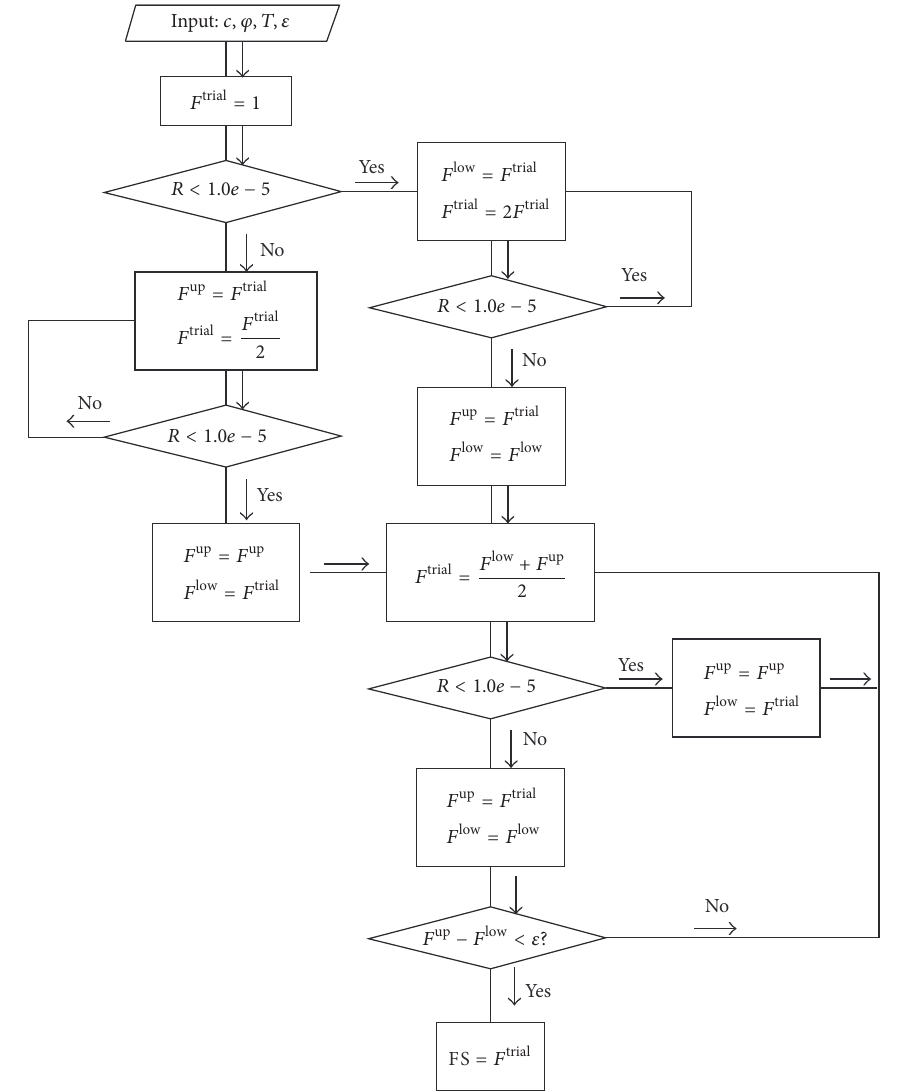
Figure 5: Numerical method for obtaining the FS of a truncated piled